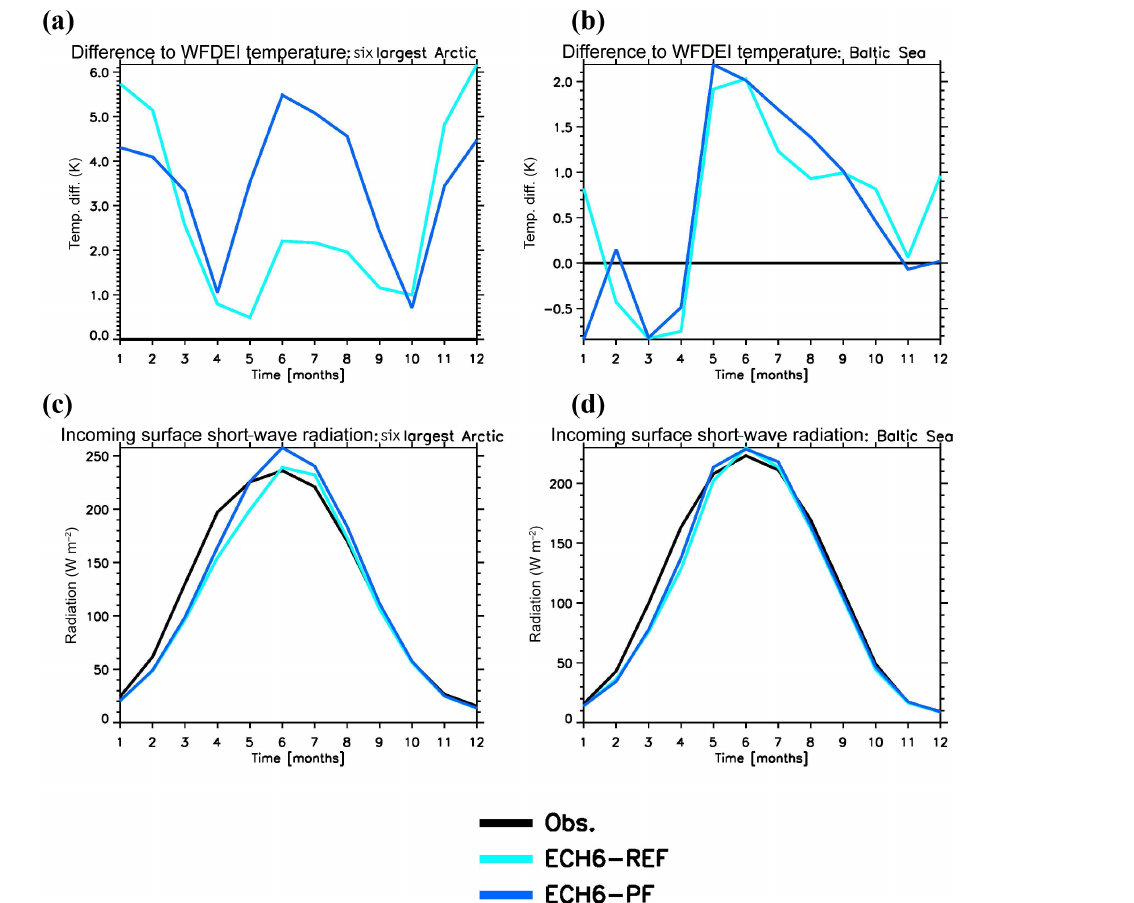
Figure 9. Mean monthly climatology (1989–2009) of 2m temperature differences to WFDEI data (upper panels) and surface solar irradiance (SSI; lower panels) over the six largest Arctic river catchments (left column) and the Baltic Sea catchment (land only, right column). SSI observations comprise CERES data for